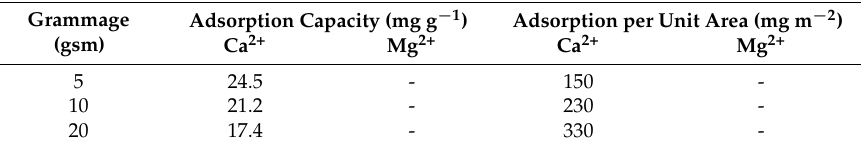
Figure 7. Adsorption of Mg 2+ (dash-dotted line) and Ca 2+ onto PT-CNF nanopapers with 5 (PT-5, full line), 10 (PT-10, dashed line) and 20 (PT-20, dotted line) gsm, respectively, per unit membrane area vs. permeate volume. Table 1. Adsorption capacities of Ca 2+ and Mg 2+ for PT-CNF nanopapers with 5, 10, and 20 gsm,